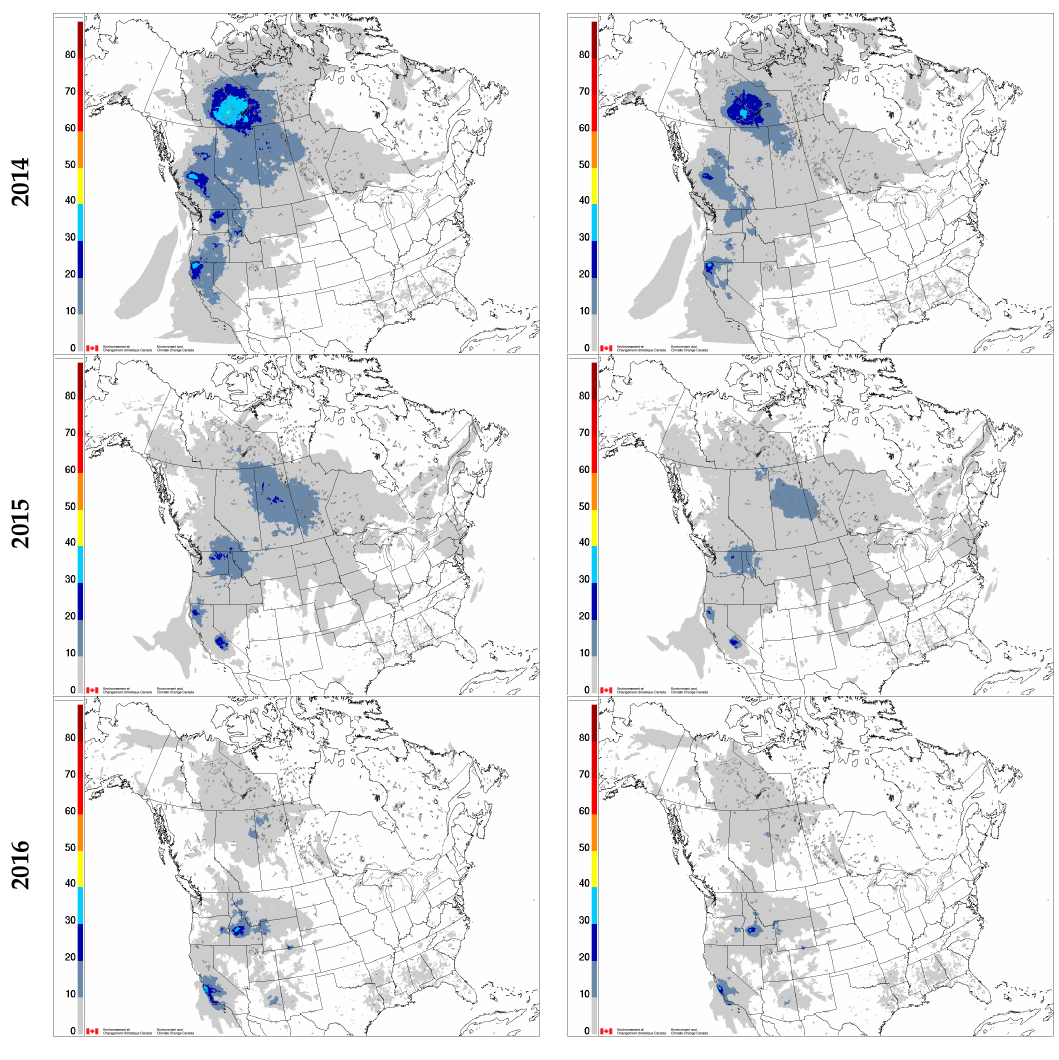
Figure 11. Same as Figure 9 but for 10 µg/m 3 .